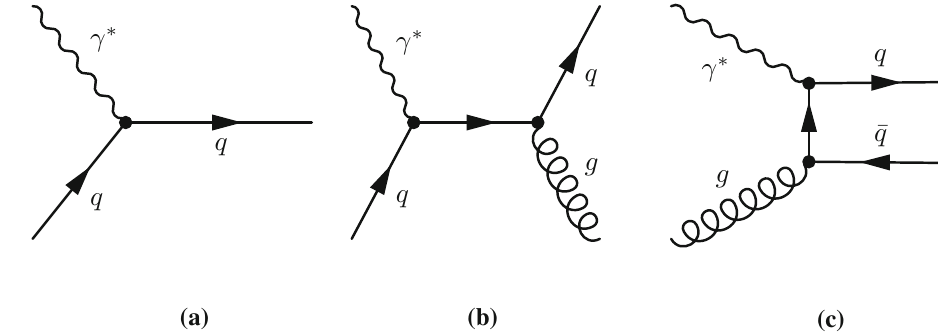
Fig. 1 Feynman diagrams for a the leading-order process (LP), b gluon radiation (QCDC), and c photon–gluon fusion (PGF)